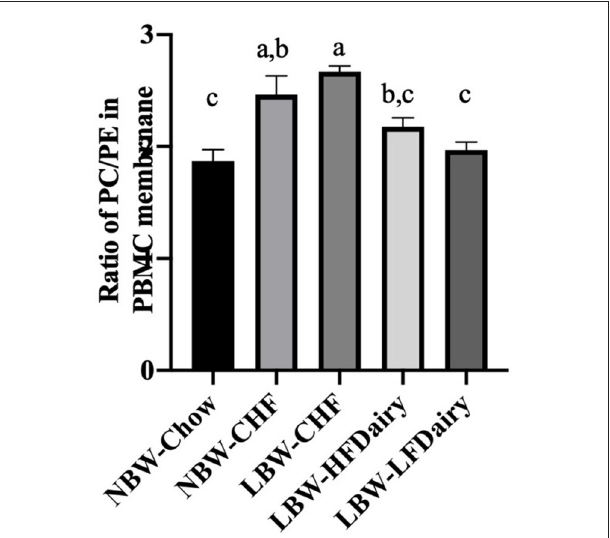
FIGURE 4 | The phosphatidylcholine to phosphatidylethanolamine ratio in PBMC membrane. CHF, control high-fat diet; HFDairy, high-fat dairy diet; LBW, low birthweight; LFDairy, low-fat dairy diet; NBW, normal birthweight; PBMC, peripheral blood mononuclear cell; PC, phosphatidylcholine; PE, phosphatidylethanolamine. All values are expressed as means ± SEM. A p -value was considered as statistically significant when < 0.05. Means sharing the same letter were not significantly different from each